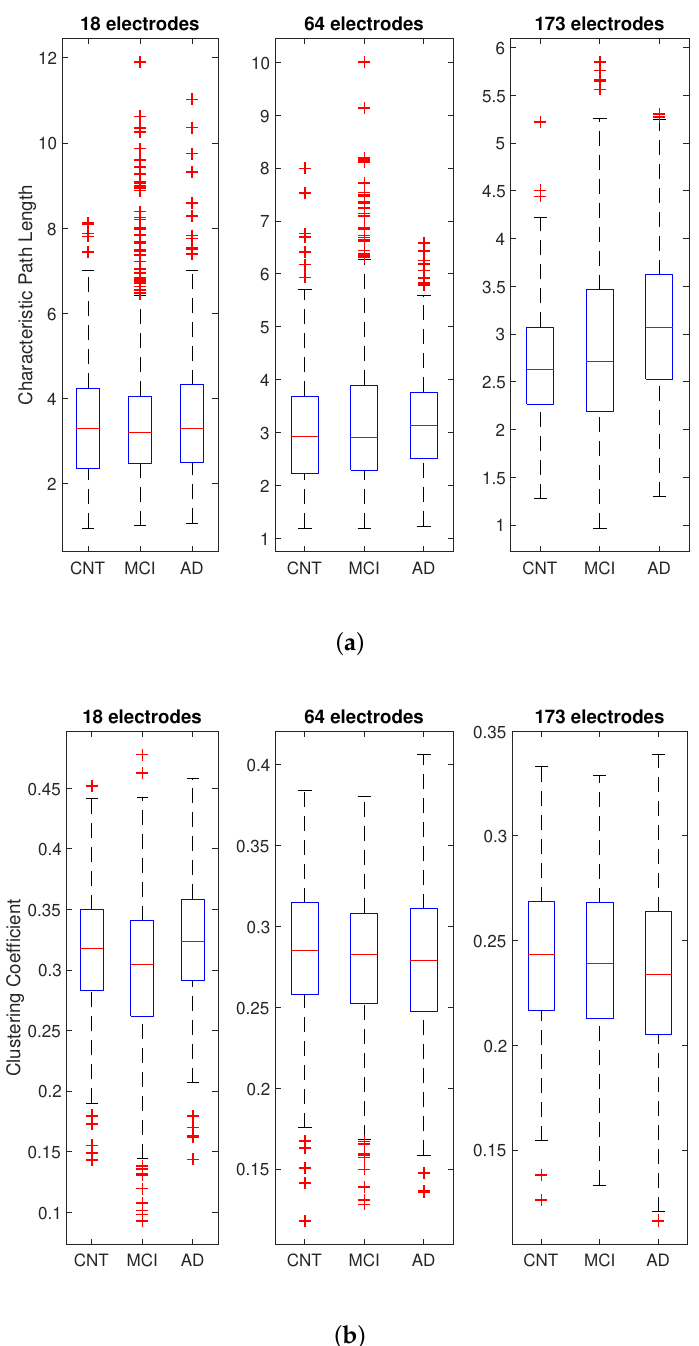
Figure 2. ( a ) Boxplot of the Characteristic Path Length of CNT, MCI, and AD; ( b ) boxplot of the Clustering Coefficient of CNT, MCI, and AD. Both are computed for three electrode configurations. The bottom and the top edges of the boxes indicate the first and the third quartile, respectively; the segment inside the boxes represents the median and the “whiskers” below and above the boxes are the minimum and maximum values of the distribution. The stars outside the whiskers are considered